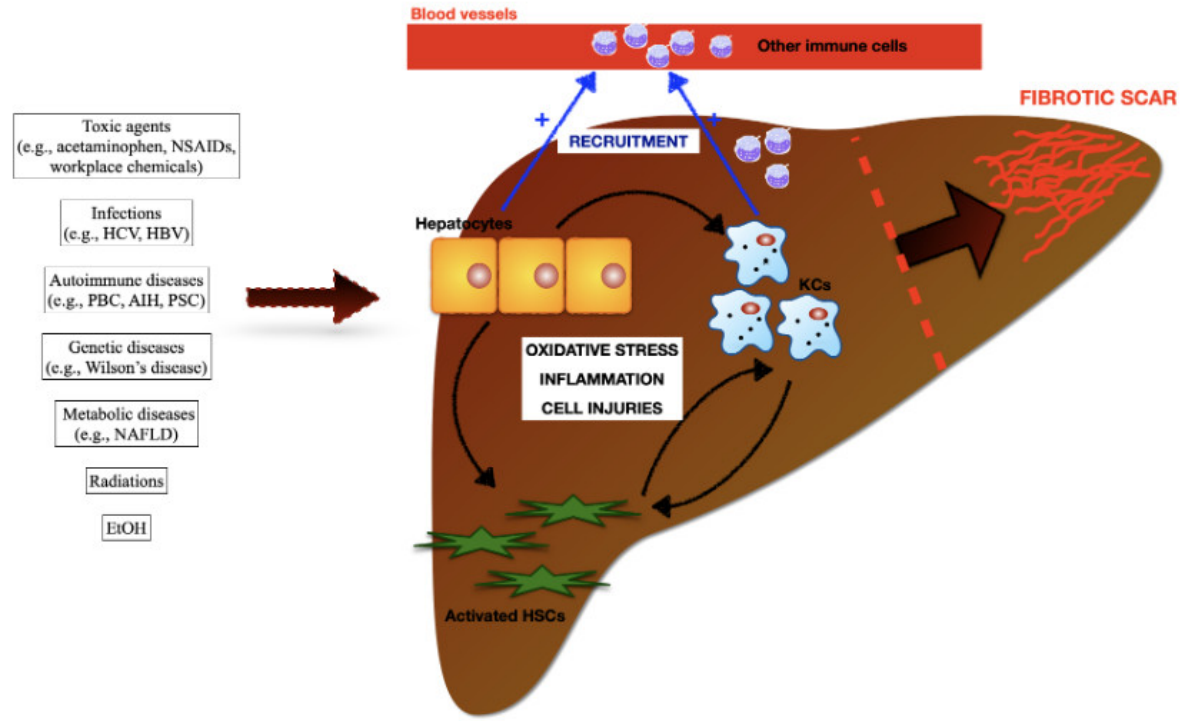
Figure 4. Schematic representation for the development of fibrotic scar in the injured liver. Liver fibrosis is the common outcome of chronic liver diseases induced by viral and helminthic in- fections, autoimmune, metabolic, and genetic conditions, exposure to toxic compounds (e.g., aceta- minophen and ethanol), and ionizing radiations (e.g., radiotherapy in cancer patients). Hepatocytes,